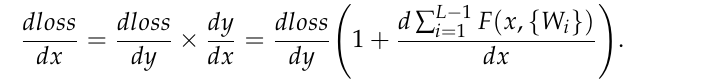
Figure 6. Calculation process of LSTM.